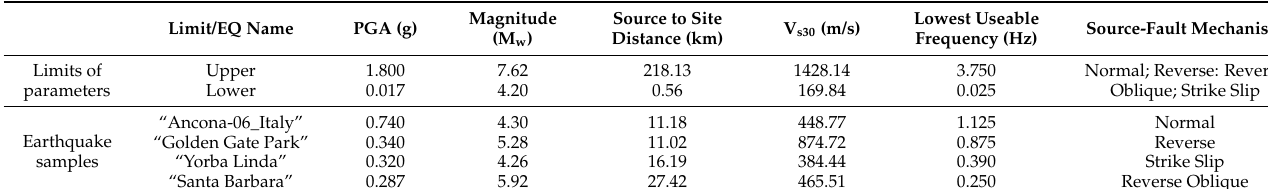
Table 2. Characteristics of the samples from 100 EQs used in NLTHA.